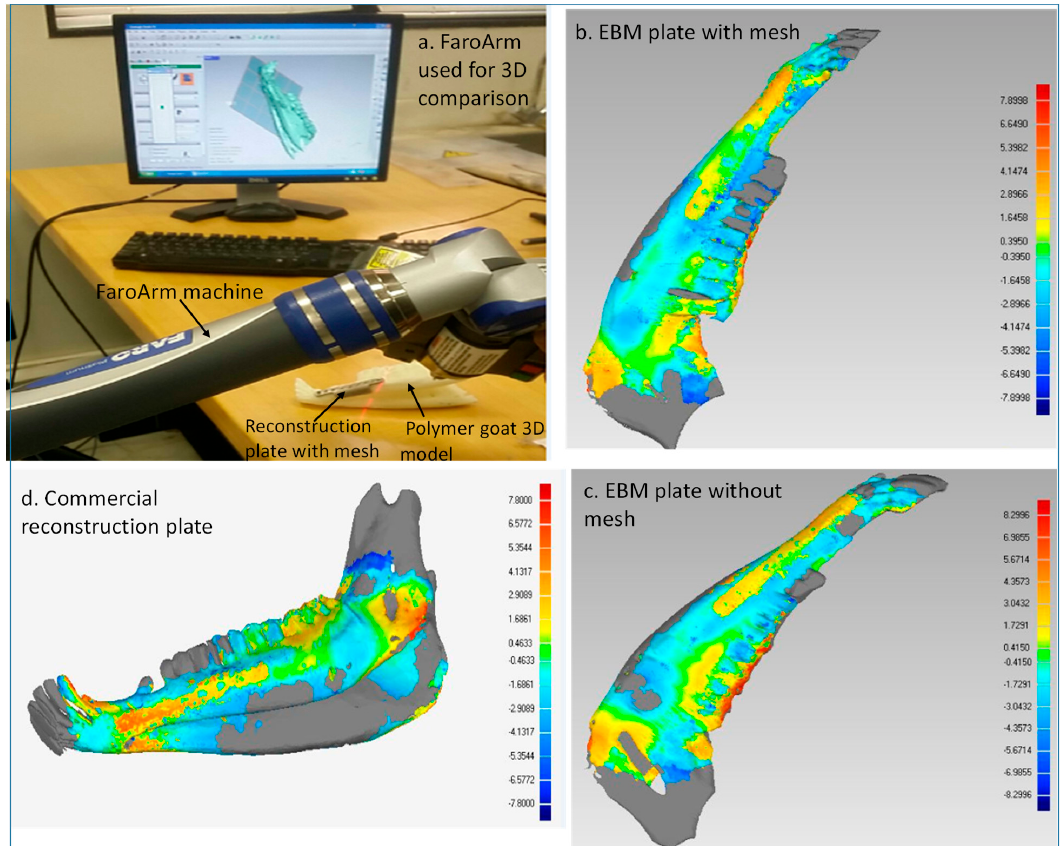
Figure 9. 3D comparison results for three reconstruction plates using Faro Arm. Metals 2019 , 9 , x FOR PEER REVIEW Second Stage: CBCT Scans